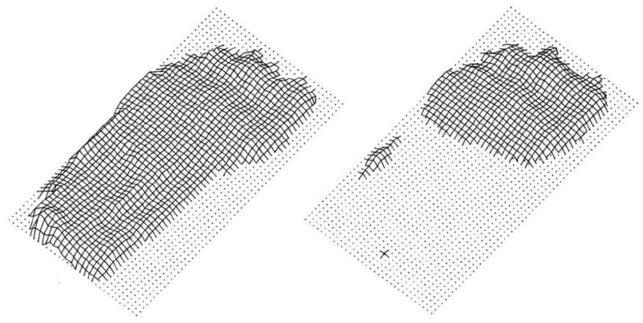
Fig. 11. Pressure patterns from the left foot at different times during the contact phase of running (after Caldwell et al.